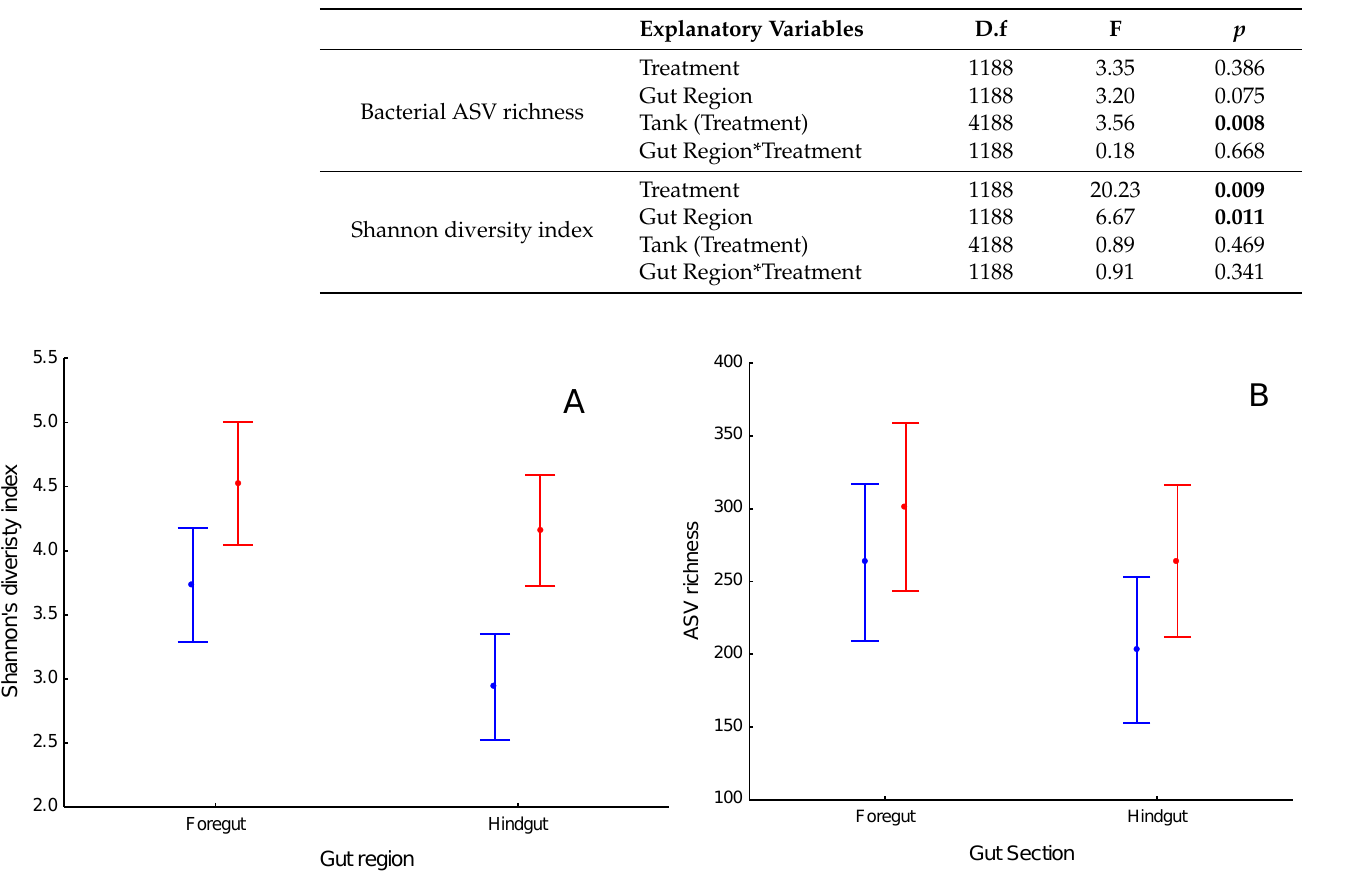
Figure 3 . ( A ) Shannon’s diversity index and ( B ) ASV richness (number of bacterial ASV) of bacterial community of foregut and hindgut of gilthead seabream juveniles fed with control (blue) and Allium supplemented diets (red). Sample size was 48 for control foregut, 55 for control hindgut, 42 for Allium -supplemented foregut, and 51 for Allium -supplemented hindgut.